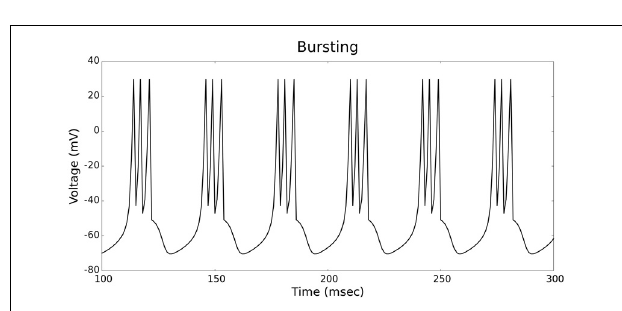
FIGURE 11 | IZH neuron model: 1s